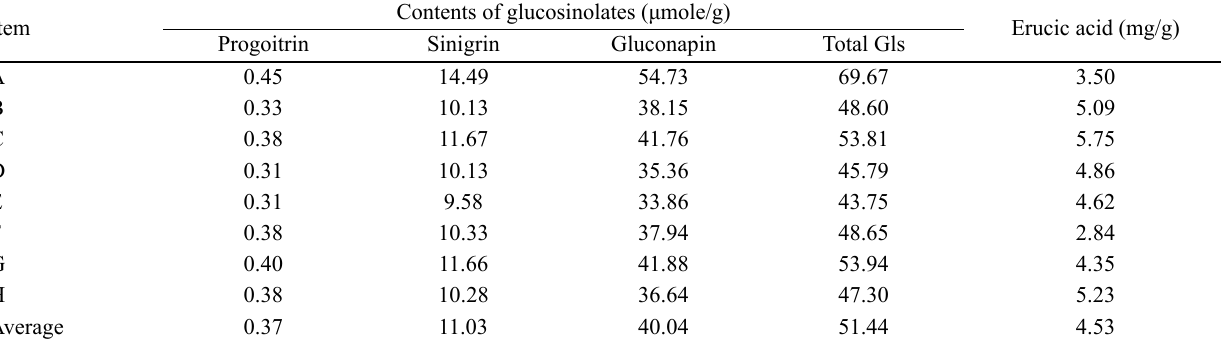
Table 4. Glucosinolates (Gls, μmole/g) and erucic acid (mg/g) contents of eight different rapeseed meal (RSM) imported from India (dry matter basis)